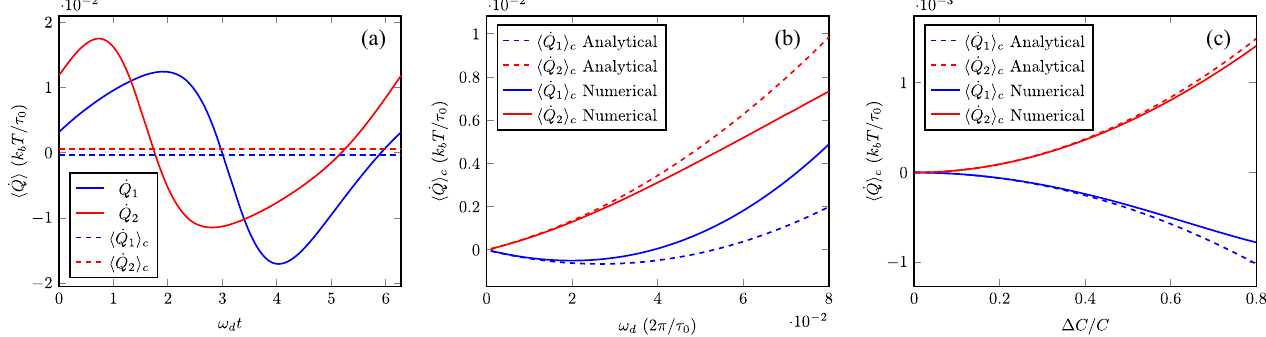
FIG. 4. (a) Asymptotic cycle of the heat currents for Δ C=C ¼ 1 = 2 and ω d = ð 2 π Þ ¼ 10 − 2 = τ d (dashed lines indicate cycle averages). (b) Average heat currents versus driving frequency for Δ C=C ¼ 0 . 5 . (c) Average heat currents versus driving strength for ω